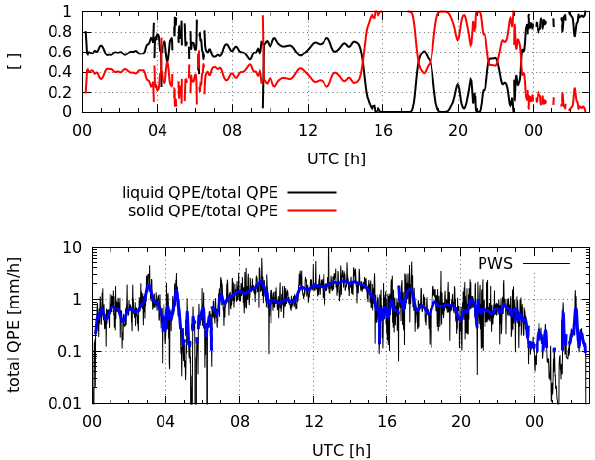
Figure 11. Raw and smoothed (in blue) time series of precipitation rate (mmh − 1 ) based on the Thies optical disdrometer (lower panel). The relative contribution of the liquid- and solid-phase precipitation to the total QPE (defined as the ratio of e.g., liquid QPE divided by the sum of liquid and solid QPE; upper panel). The ratio is only computed for precipitation rates larger than 0.1mm. The resulting time series is then smoothed with a spline fit. Data shown begin at 00:00UTC, 5 January 2013.